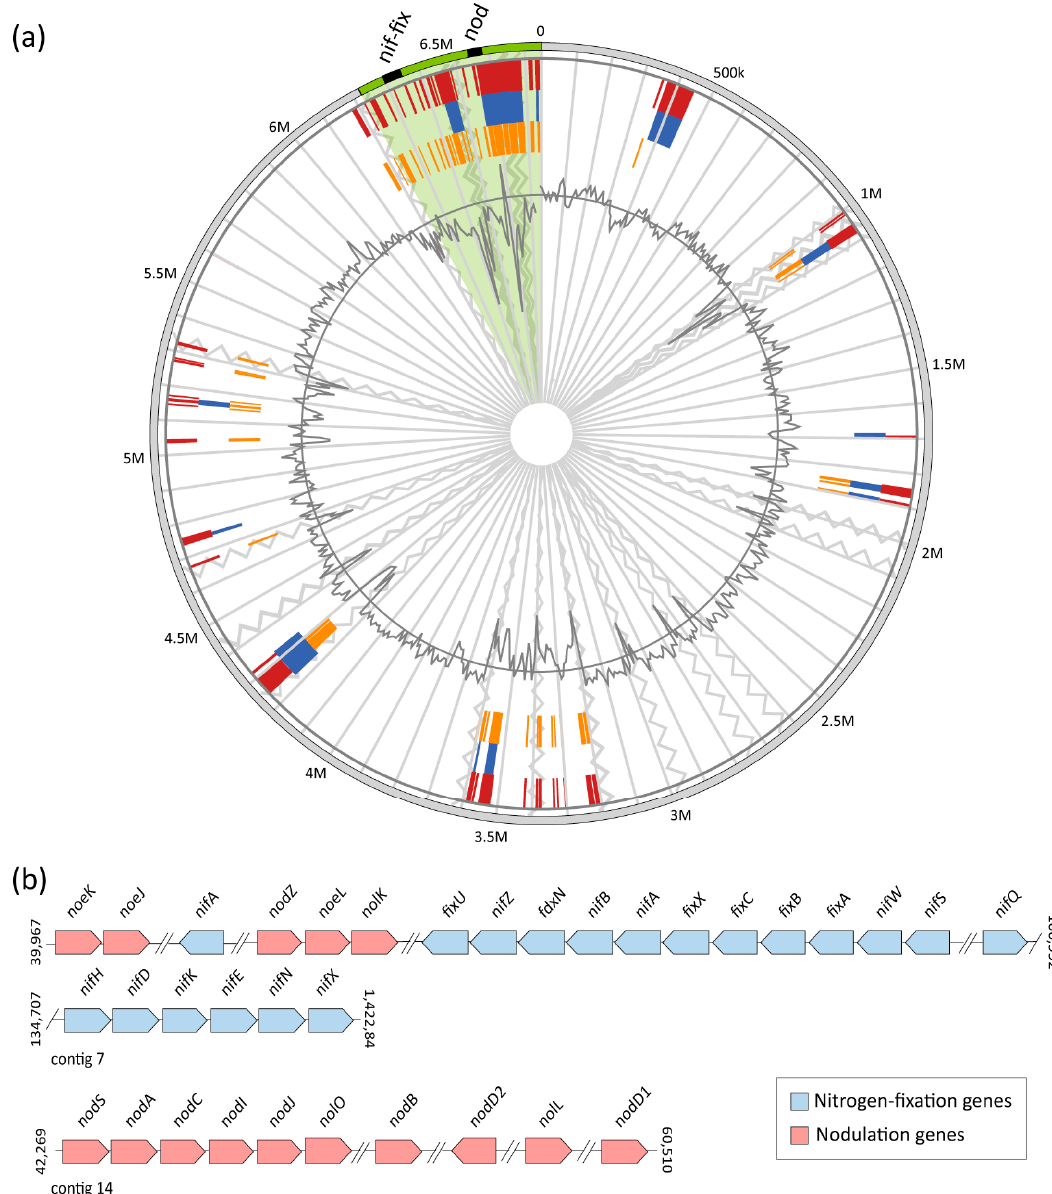
Figure 5. ( a ) Genomic island prediction in the A. anthyllidis LMG 26462 T genome. The draft genome of A. anthyllidis LMG 26462 T was aligned on the reference genome of Aminobacter sp. SR38. Circular visualization of the predicted genomic island is shown, with blocks colored according to the prediction method; IslandPath-DIMOB (blue) and SIGI-HMM (orange), as well as the integrated results (dark red). The outermost circle (grey) represents aligned contigs, while a region of unaligned contigs, which corresponds to a ca. 500 kb genomic island, is highlighted in green. Black zig-zag line demarcates each of the 30 contigs identified in A. anthyllidis LMG 26462 T . The innermost black plot represents the GC content (%). The nod and nif-fix gene clusters are shown in black within the symbiosis island region in the outermost circle; ( b ) Organization of nitrogen-fixation and nodulation genes predicted in the A. anthyllidis LMG 26462 T symbiosis island, colored according to nod/nif-fix pathways (see key). Coordinates are numbered according to the first base of each contig. Double slash marks denote genome regions that are not shown. The gene map is not to